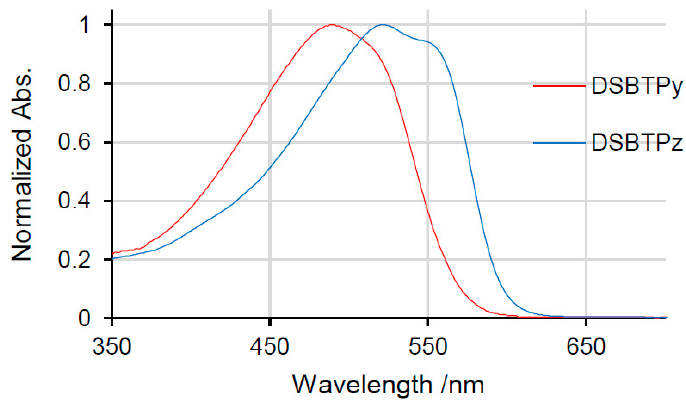
Figure 1. Absorption spectra of DSBTPy and DSBTPz in o -dichlorobenzene. Reproduced from Reference [29]—Published by the Royal Society of Chemistry.